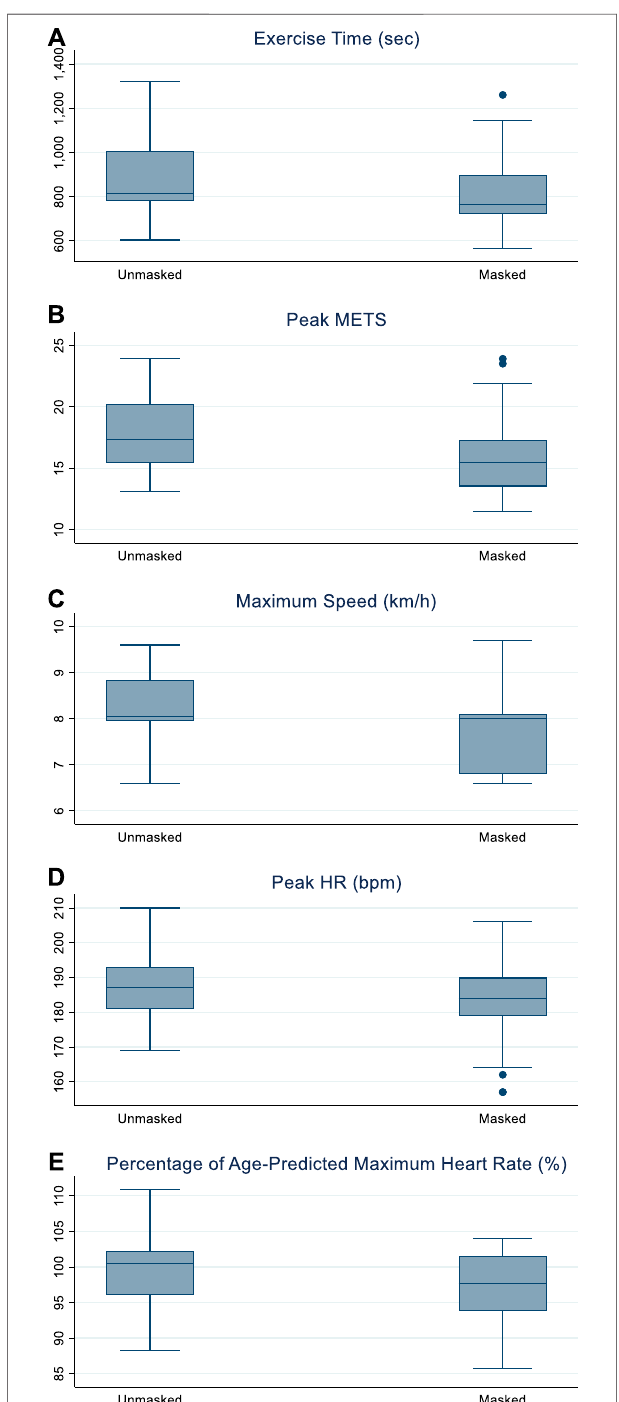
FIGURE 2 | Exercise time (seconds), peak metabolic equivalents (METS), maximum speed (km/hour), peak heart rate (beats per minute), percentage of age-predicted maximum heart rate (%), in masked and unmasked individuals.